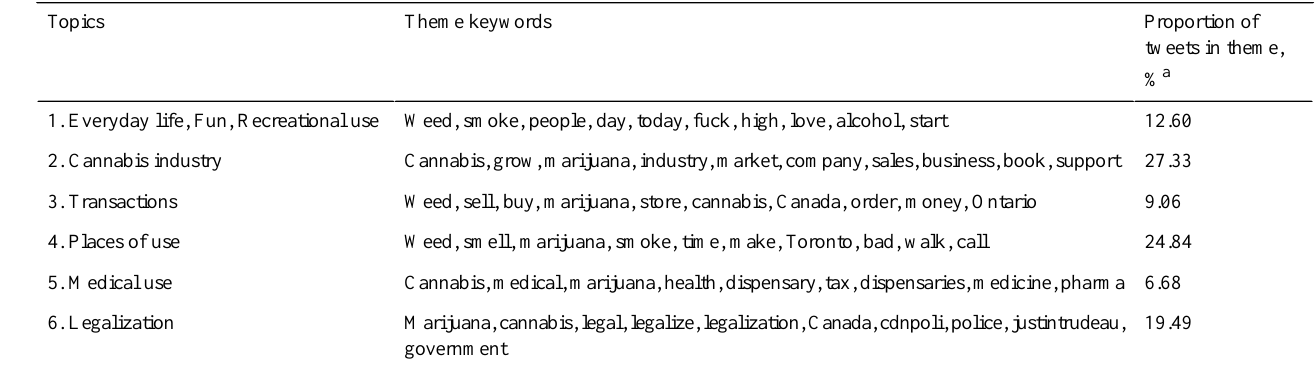
Table 3. Topics found in content analysis for cannabis-related tweets by state legal category groupings, Canada, January 2017-2019